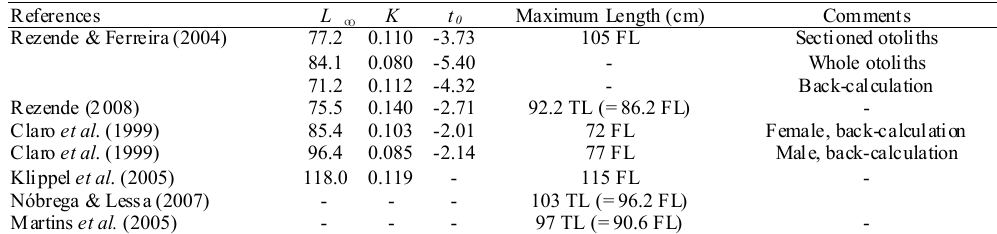
Table 5. Von Bertalanffy growth parameters estimates and maximum length reported in the literature for the dog snapper Lutjanus jocu . FL = Fork length and TL = Total